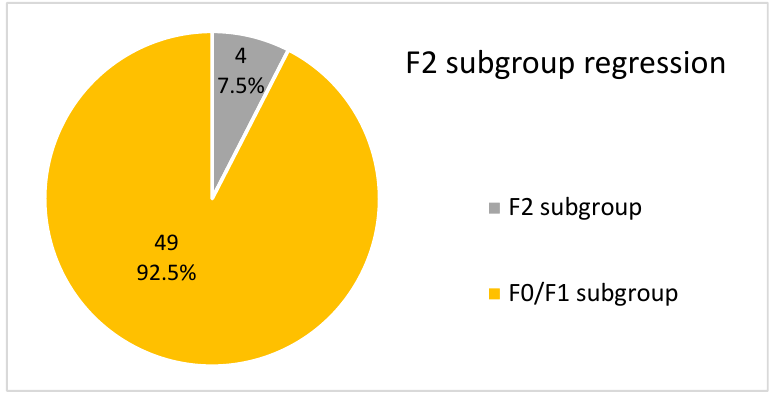
Figure 12. Graphic description of the fibrotic stage in F2 patients at the end of the follow-up period. Overall, non-cirrhotic patients had a greater and faster regression to a lower fibrotic stage than cirrhotic patients.